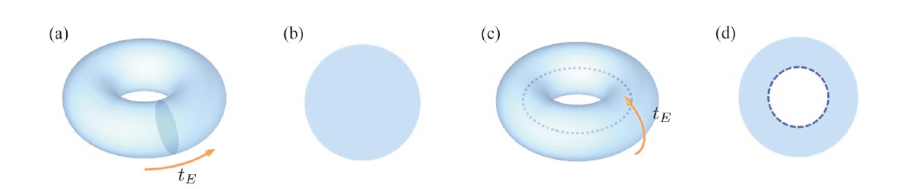
Figure 1 . From left to right: (a) Geometry for Euclidean thermal AdS 3 , with time going along the longitudinal direction; (b) The constant time slice of (a) is a disk; (c) Geometry for Euclidean BTZ black hole, with the event horizon being the dashed line in the core of the solid torus; (d) Constant time slice of (c) is an annulus,where the inner boundary is the event